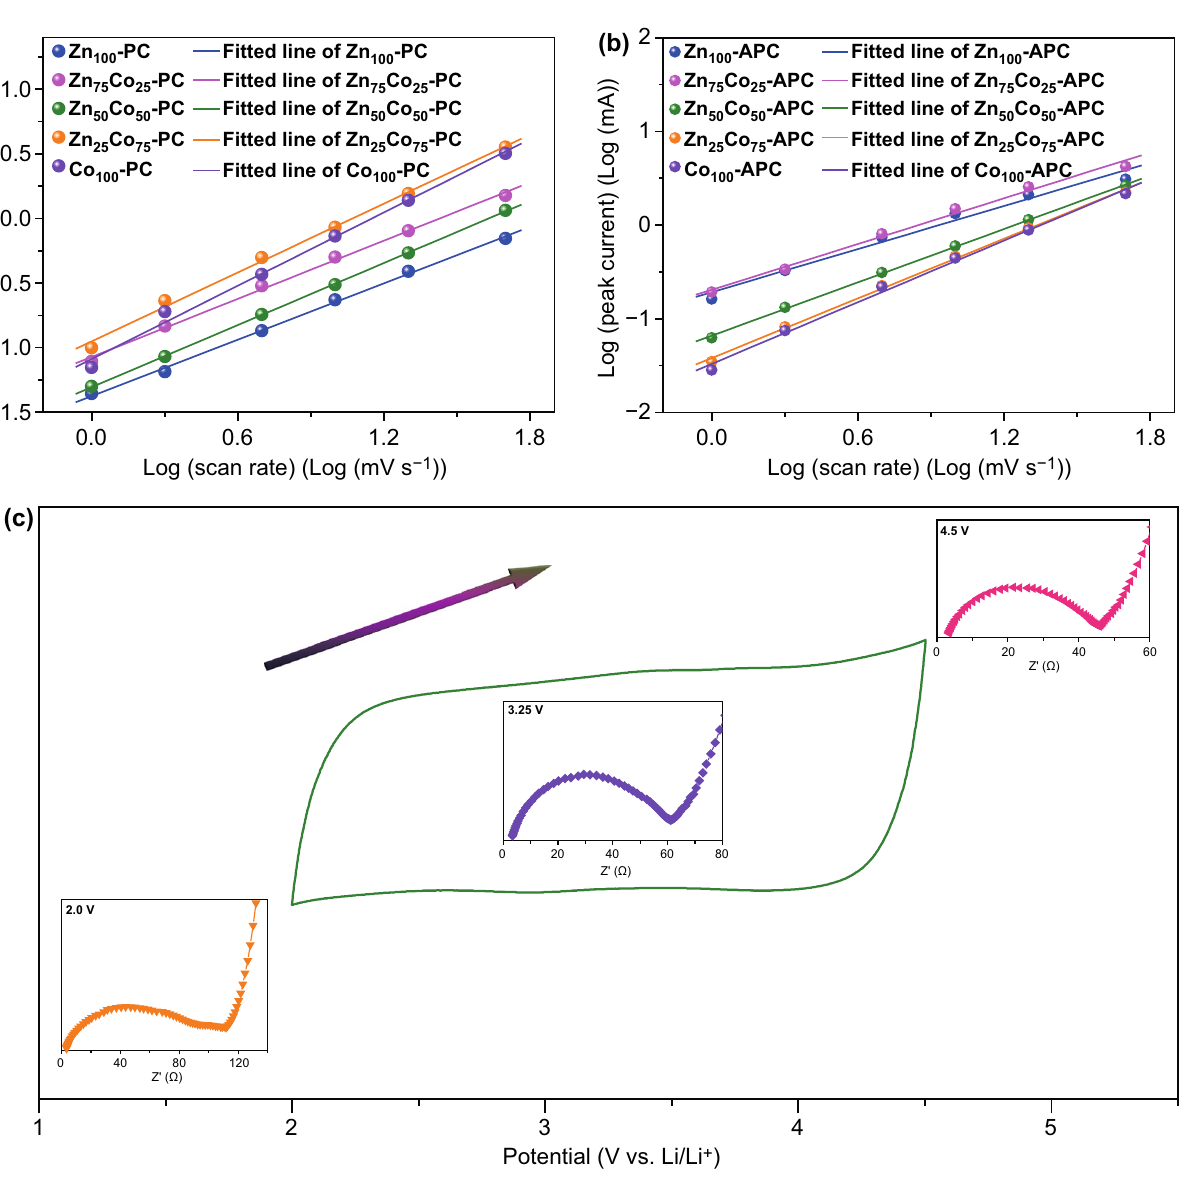
Fig. 5 Determination of the b ‑value using the relationship between the peak current and the scan rate of a Zn x Co 100− x –PCs and b Zn x Co 100− x – APCs. c Illustration of variation of Nyquist plots under different open‑circuit voltages by taking Co 100 ‑APC as an